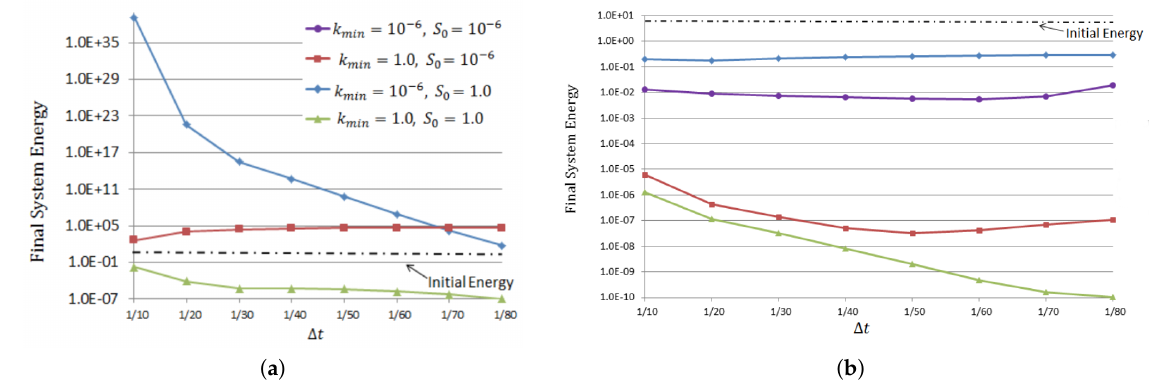
Figure 4. Final system energy E N versus time-step size for ( a ) CNLF, and ( b ) CNLFstab, [44].